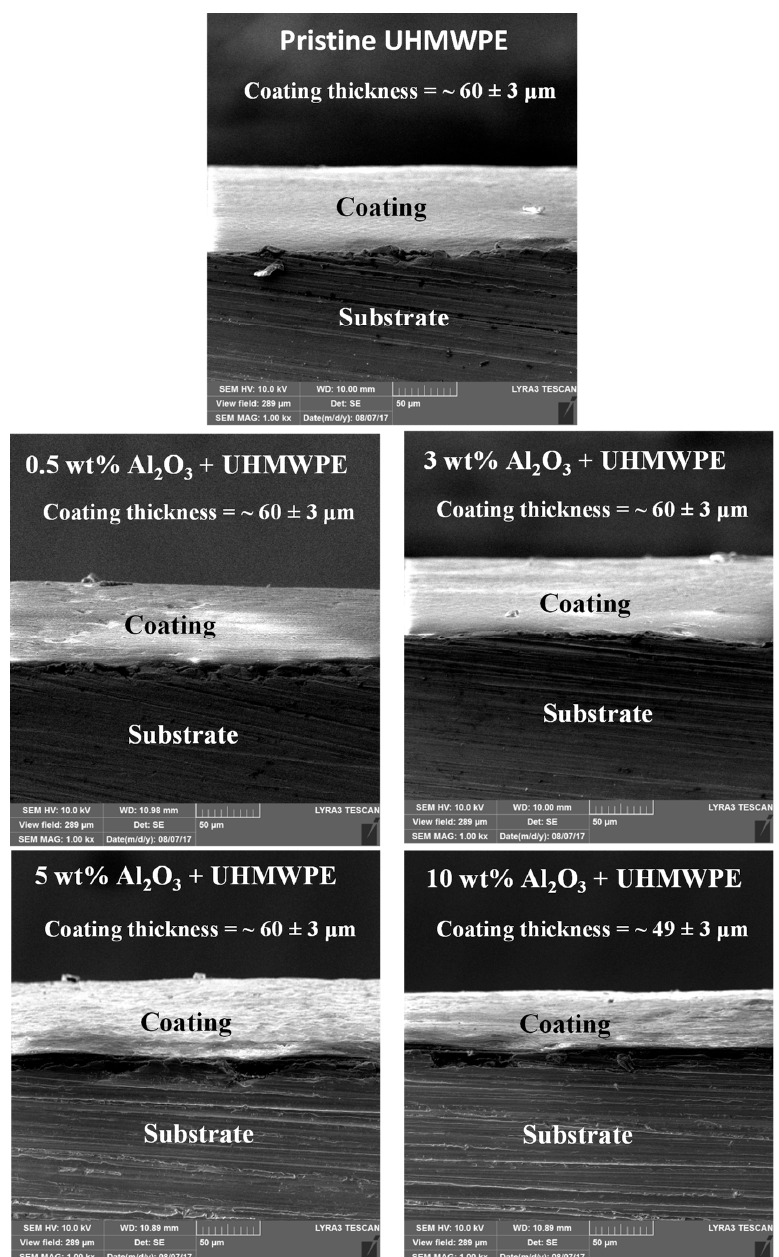
Figure 5. FESEM cross-sectional images of the coating/substrate system for the pristine and the nanocomposite